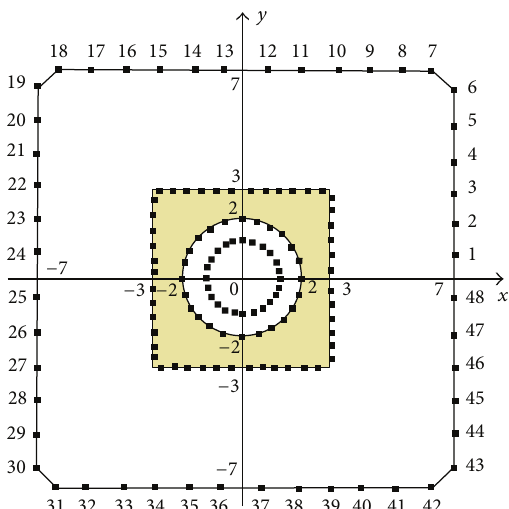
Figure 6: Domain Ω 1 encircled by singular points.